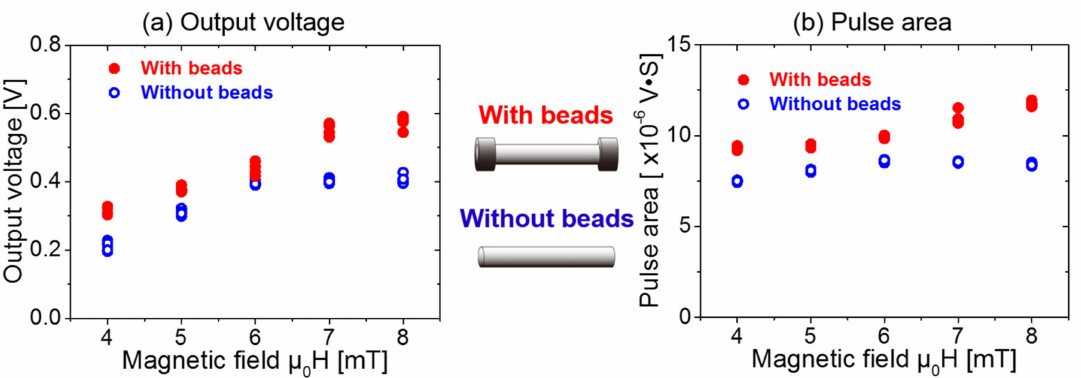
Figure 8. Comparison of the experimental results of the amplitude and the area of the Wiegand pulse with or without ferrite beads, displaying: ( a ) output voltage and ( b ) pulse area. (The meanings of amplitude and area of the pulse are described in Figure